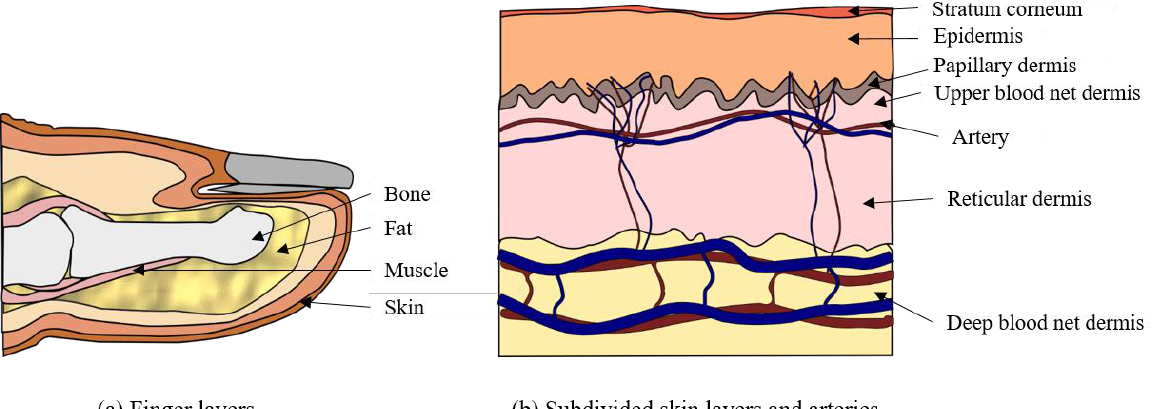
Figure 2. Proposed finger model.